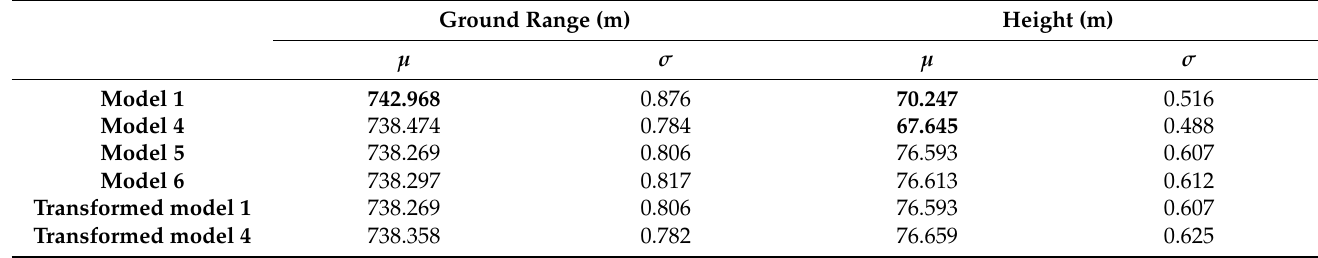
Table 8. The quantitative analysis of inversion results using measured data. Ground Range